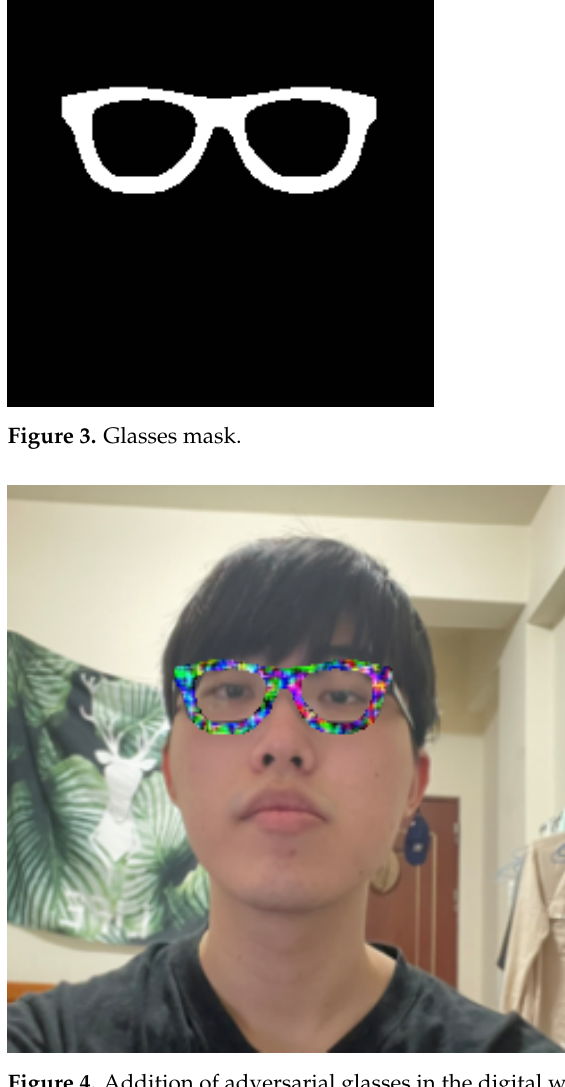
Figure 4. Addition of adversarial glasses in the digital